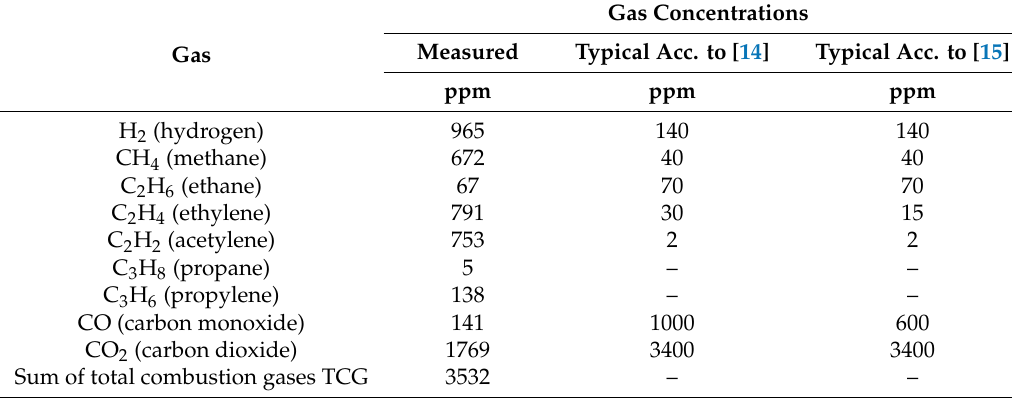
Table 8. Results of the measurements of the gas concentrations in the oil sample taken from the bushing of the 1U phase after the lightning tests (exceedance of the typical values is marked in bold font).